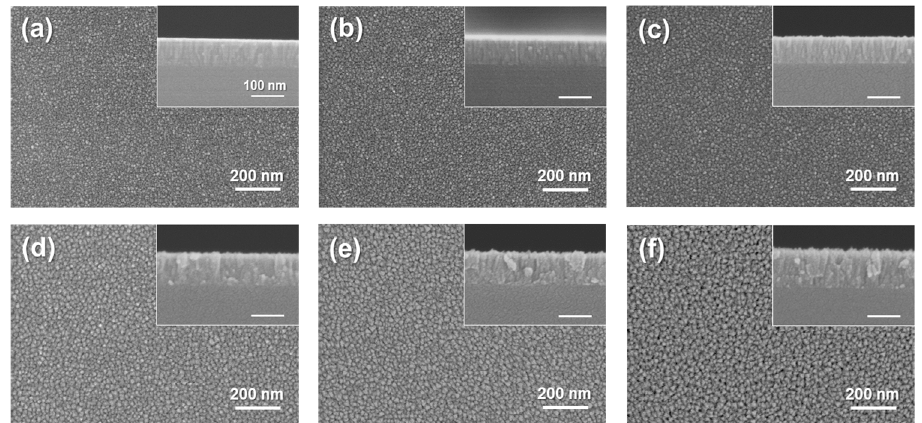
Figure 4. SEM surface morphology of TiN thin film deposited with various working pressure: ( a ) 0.25 mTorr, ( b ) 0.5 mTorr, ( c ) 1 mTorr, ( d ) 2 mTorr, ( e ) 3 mTorr, and ( f ) 5 mTorr. The inset presents a SEM image of TiN thickness.